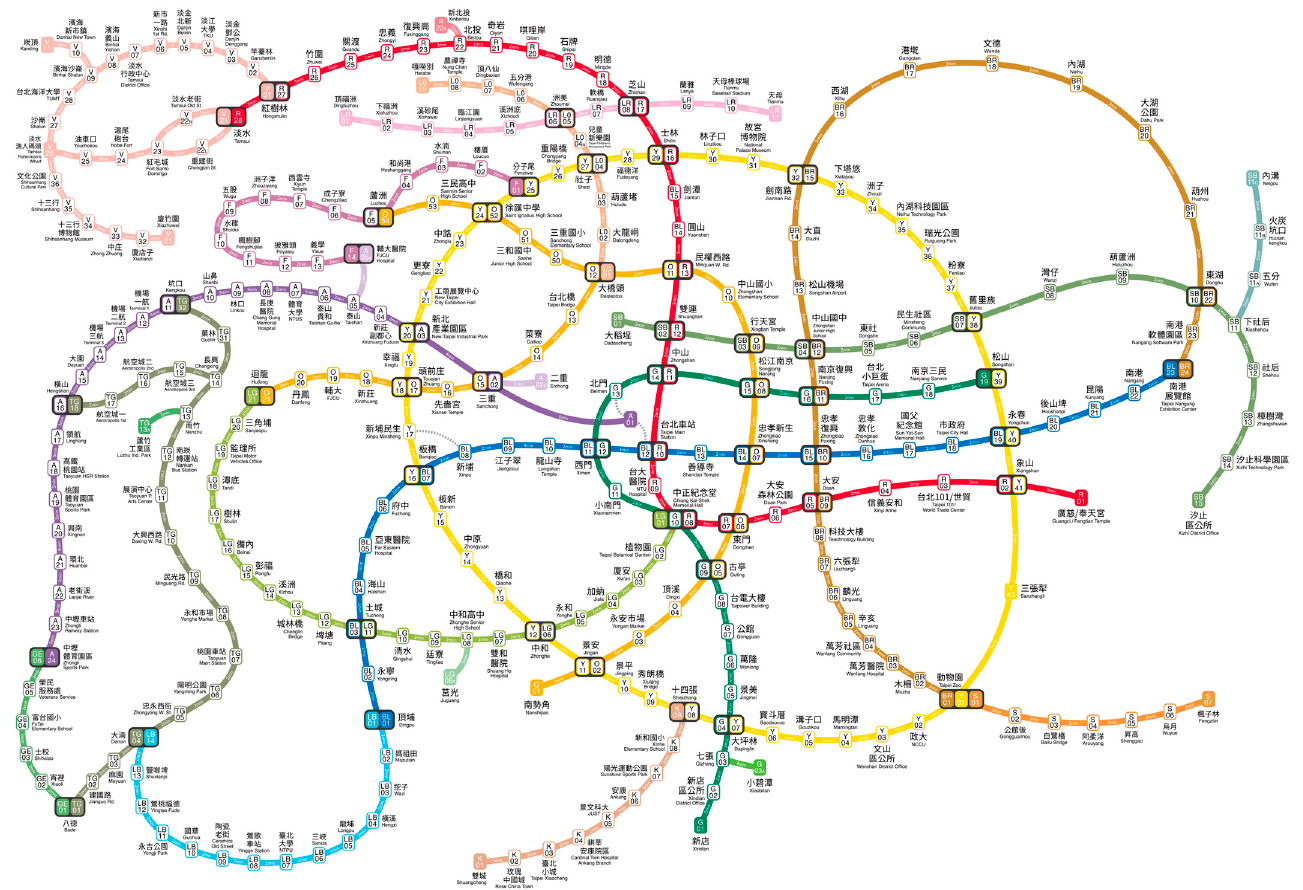
Figure 10. Route map C.